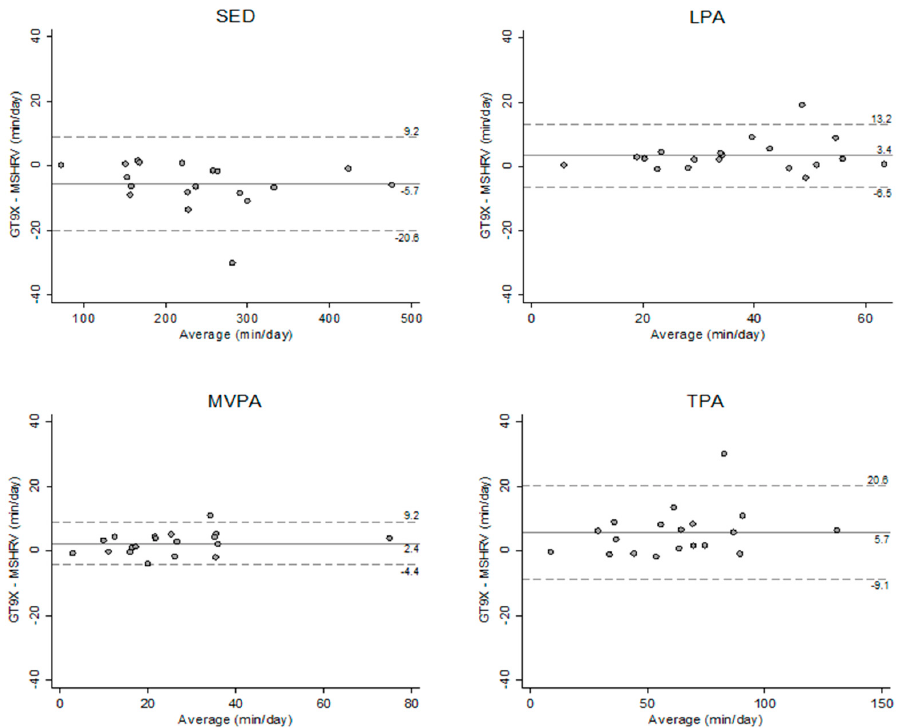
Figure 3. Bland–Altman plots illustrating the level of agreement in sedentary behavior and PA estimates between the GT9X and MotionSense HRV (MSHRV) under free ‐ living conditions. Dashed lines show 95% limits of agreement (± 1.96 standard deviation). SED: sedentary behavior; LPA: light PA; MVPA: moderate ‐ to ‐ vigorous PA; TPA: total PA.